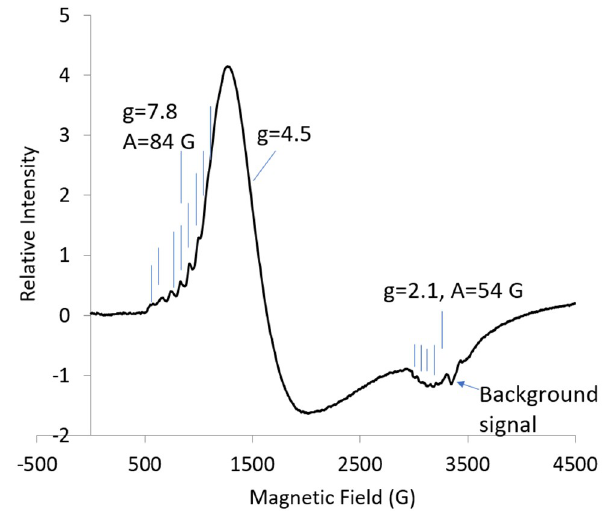
Figure 1. X-band (9.631 GHz) electron paramagnetic resonance (EPR) spectrum for the Co complex of ethylene diamine tetraacetic acid (CoEDTA) (1 mM): temp., 8 K; microwave power, 10 dB; nine scans averaged. Vertical lines indicate the Co hyperfine lines, eight for g = 7.8 and four of eight for g = 2.1, also indicate the g-values.